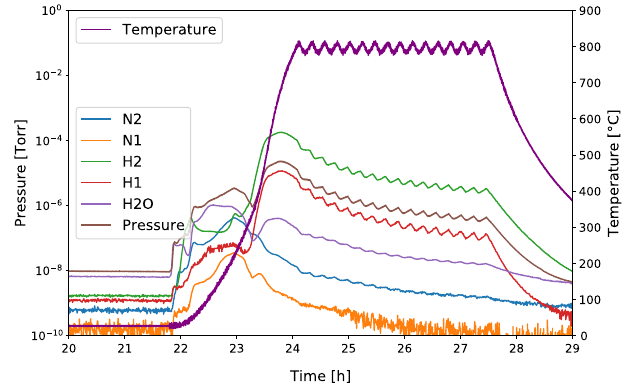
FIG. 6. Sample degassing treatment of the HWR at 800° C. Shown are also partial pressures of gases of interest, showing a strong removal of hydrogen from the cavity.